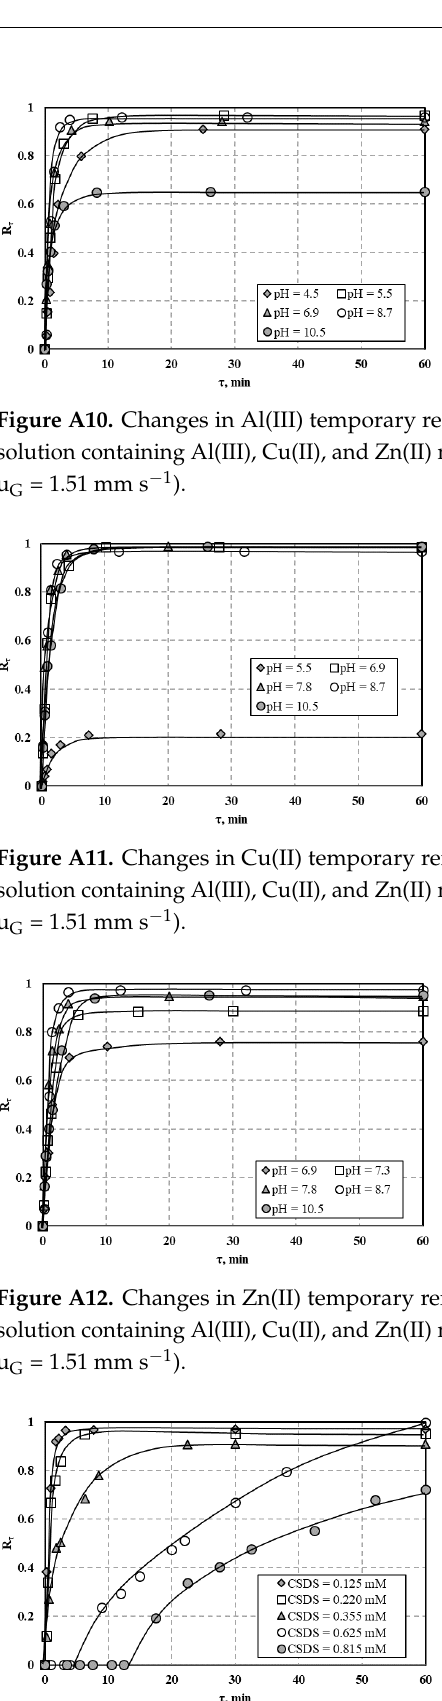
Figure A13. Changes in Al(III) temporary removal ratio during precipitate flotation from solution containing Al(III), Cu(II), and Zn(II) mixture—effect of collector concentration (c 0 = 0.15 mmol dm − 3 , pH = 8.0, u G = 1.51 mm s − 1 ).